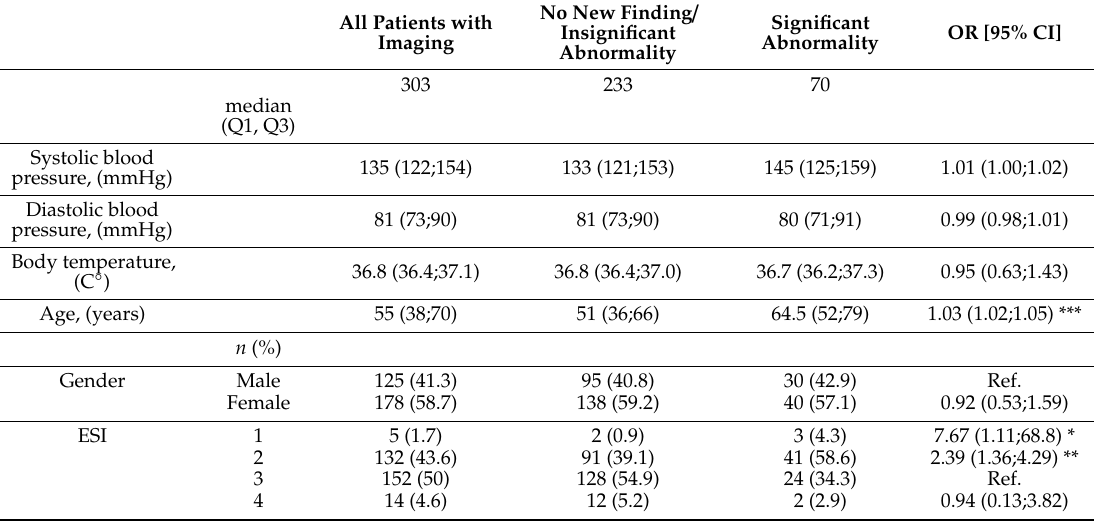
Table 3. Univariate analysis of features predictive of significant intracranial